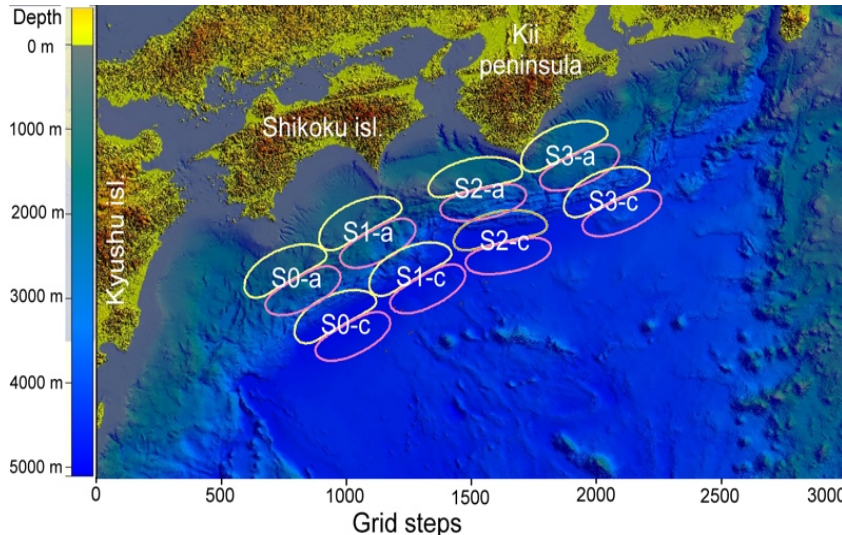
Figure 3. Digital bathymetry around Kii Peninsula and Shikoku Island (Japan) [13]. The positions of tsunami model sources are indicated. Pairs of ellipses, indicated as Si-a and Si-c ( i = 0, 1, 2, 3), show the positions of the artificial tsunami sources.